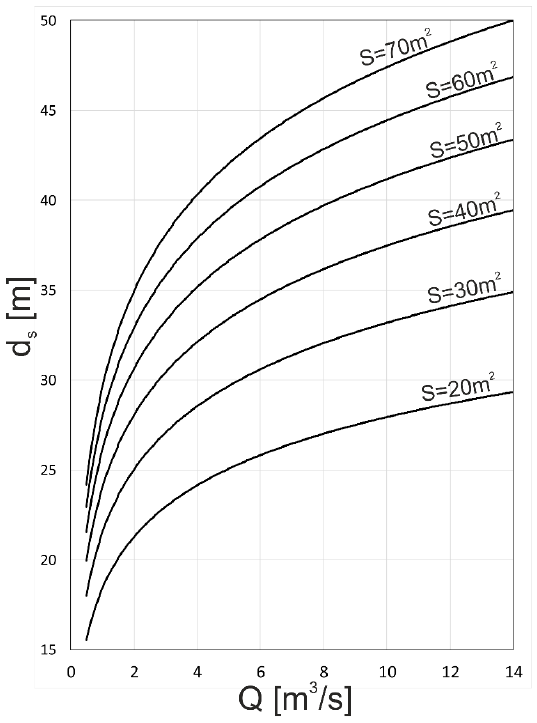
Figure 15. Maximum possible duct end-to-face distance for some ventilation of the dead zone, in terms of airflow rate and tunnel section.